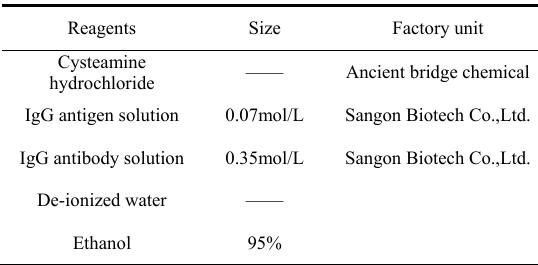
Table 2 Materials and reagents required in the